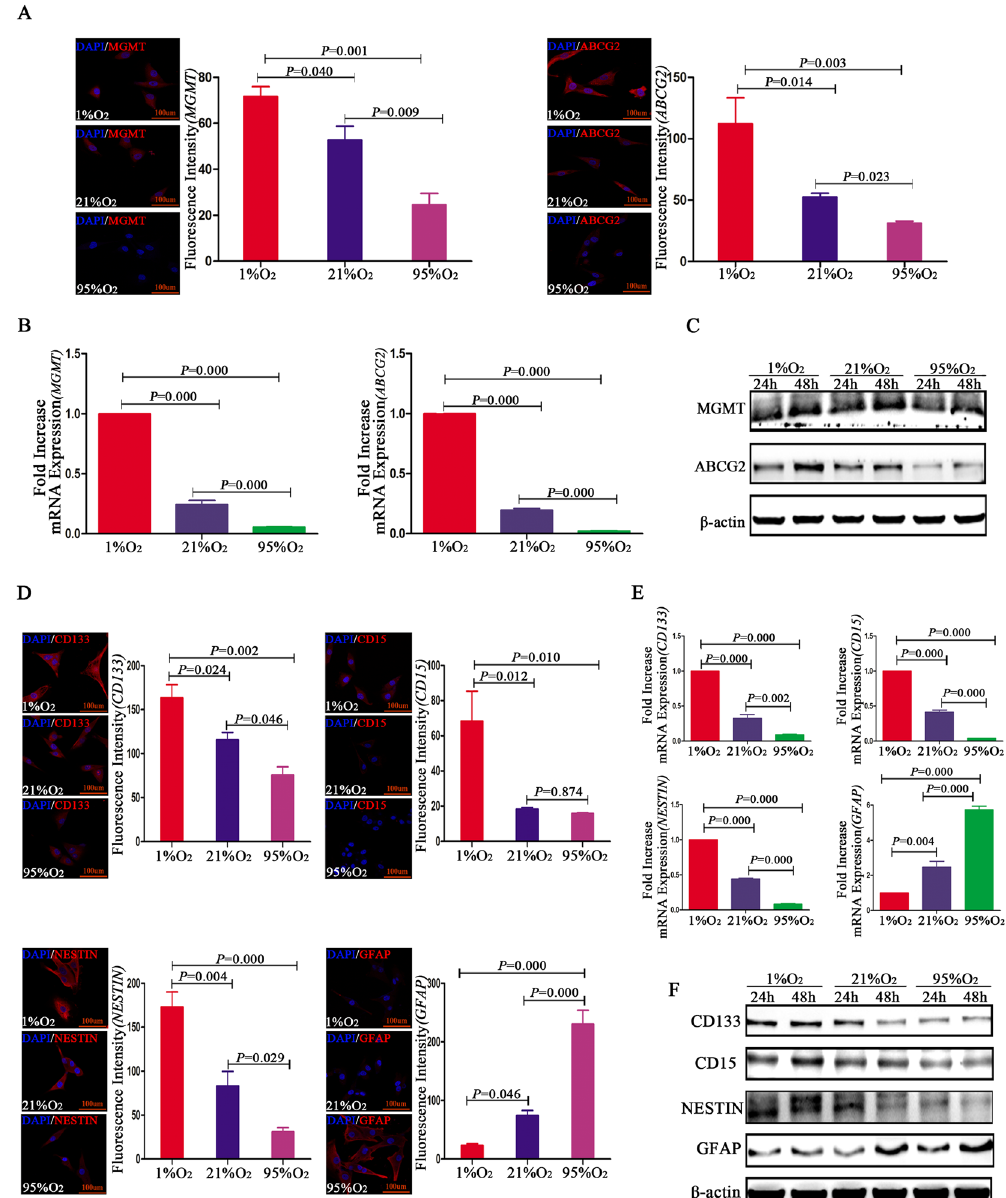
Figure 2. Protein detection for CD133 − /CD15 − /NESTIN − glioma cells under different oxygen levels. ( A ) Higher MGMT and ABCG2 levels were detected for GL261 CD133 − CD15 − NESTIN − cells under 1%O 2 conditions for 24 h than 21%O 2 or 95%O 2 via immunofluorescence staining. Cells demonstrated the lowest expression in 95%O 2 ( P < 0.05, One-way ANOVA). ( B ) A 5-fold increase of MGMT in 1%O 2 was identified for GL261 CD133 − CD15 − NESTIN − cells via RT-qPCR compared with normoxia, and MGMT was fewer in 95%O 2 . Similar results were obtained for ABCG2 in different oxygen levels ( P < 0.05, One-way ANOVA). ( C ) There were significant differences in MGMT and ABCG2 for GL261 CD133 − CD15 − NESTIN − cells under different oxygen levels in western blot; the highest expression was identified in 1%O 2 , and the lowest expression was demonstrated in 95%O 2 ( P < 0.05, One-way ANOVA). Both MGMT and ABCG2 increased levels in a time dependent manner from hypoxia for 24 to 48 h. However, under hyperoxia, MGMT expression remained stable; for ABCG2, there was lower expression after hyperoxia treatment ( P < 0.05, One-way ANOVA). ( D ) Compared with 21%O 2 or 95%O 2 , increased CD133, CD15 and NESTIN levels were identified for GL261 CD133 − CD15 − NESTIN − cells in 1%O 2 via immunofluorescence staining. Cells demonstrated the lowest expression after exposure in 95%O 2 . In contrast, GFAP was highly expressed after hyperoxia exposure for 24 h, which exhibited 3-fold increases compared with normoxia and 12-fold compared with hypoxia. There was almost no GFAP expression in the 1%O 2 or 21%O 2 microenvironments ( P < 0.05, One-way ANOVA). ( E ) RT-qPCR indicated the CD133, CD15 and NESTIN levels significantly increased in 1%O 2 for 12 h compared with 21%O 2 and 95%O 2 for GL261 CD133 − CD15 − NESTIN − cells. However, the GFAP levels increased in an oxygen concentration-dependent manner, and GFAP was 3-fold higher under hyperoxia than normoxia and 6-fold higher than hypoxia.